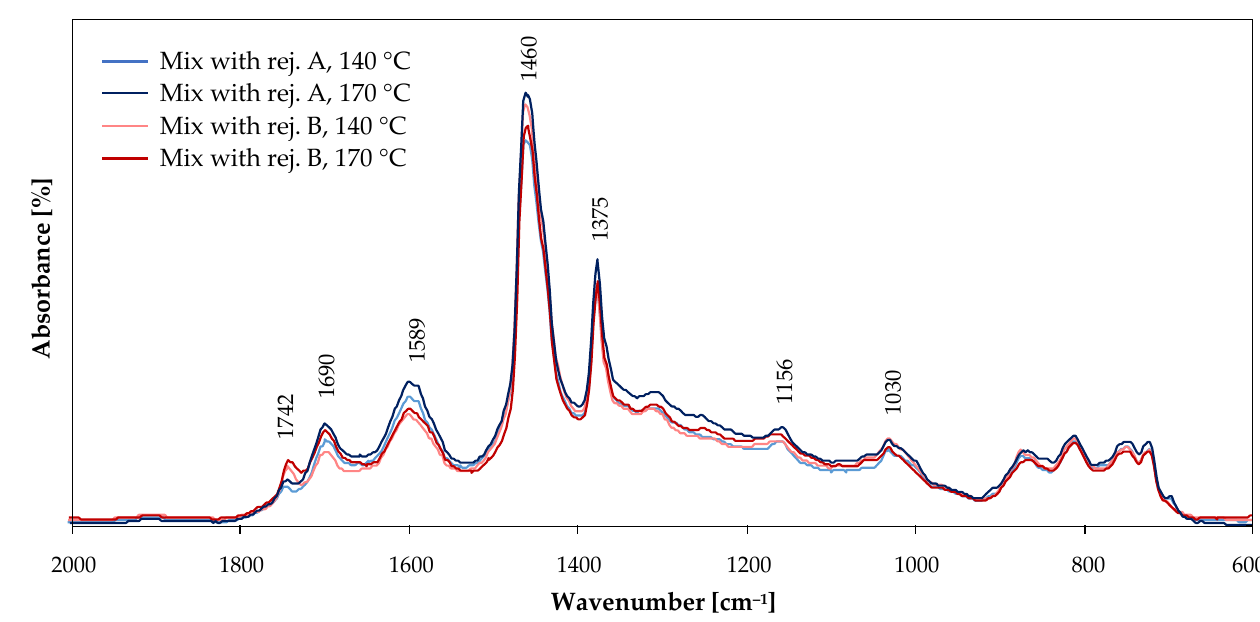
Figure 6. Absorbance spectra from FTIR analysis on the extracted binders.